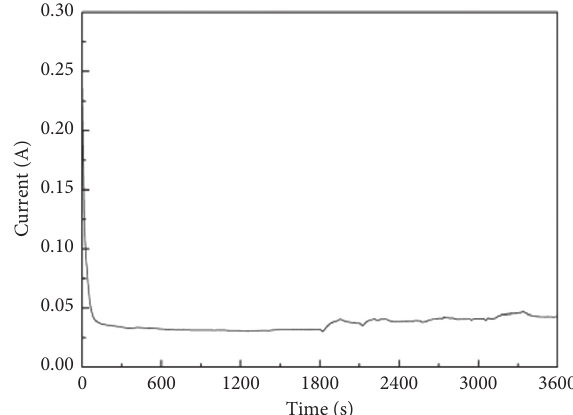
Figure 5: The I - t curve of stainless steel samples anodized.